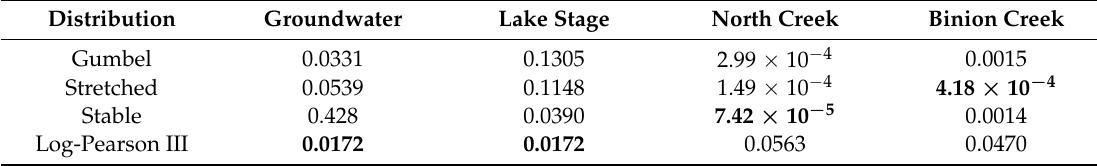
Table 3. The RMSE of each of the calculated distributions for the different water systems. Numbers shown for the creeks are RMSE for fitting the stream discharge. The lowest RMSE is highlighted by bold font for each distribution.